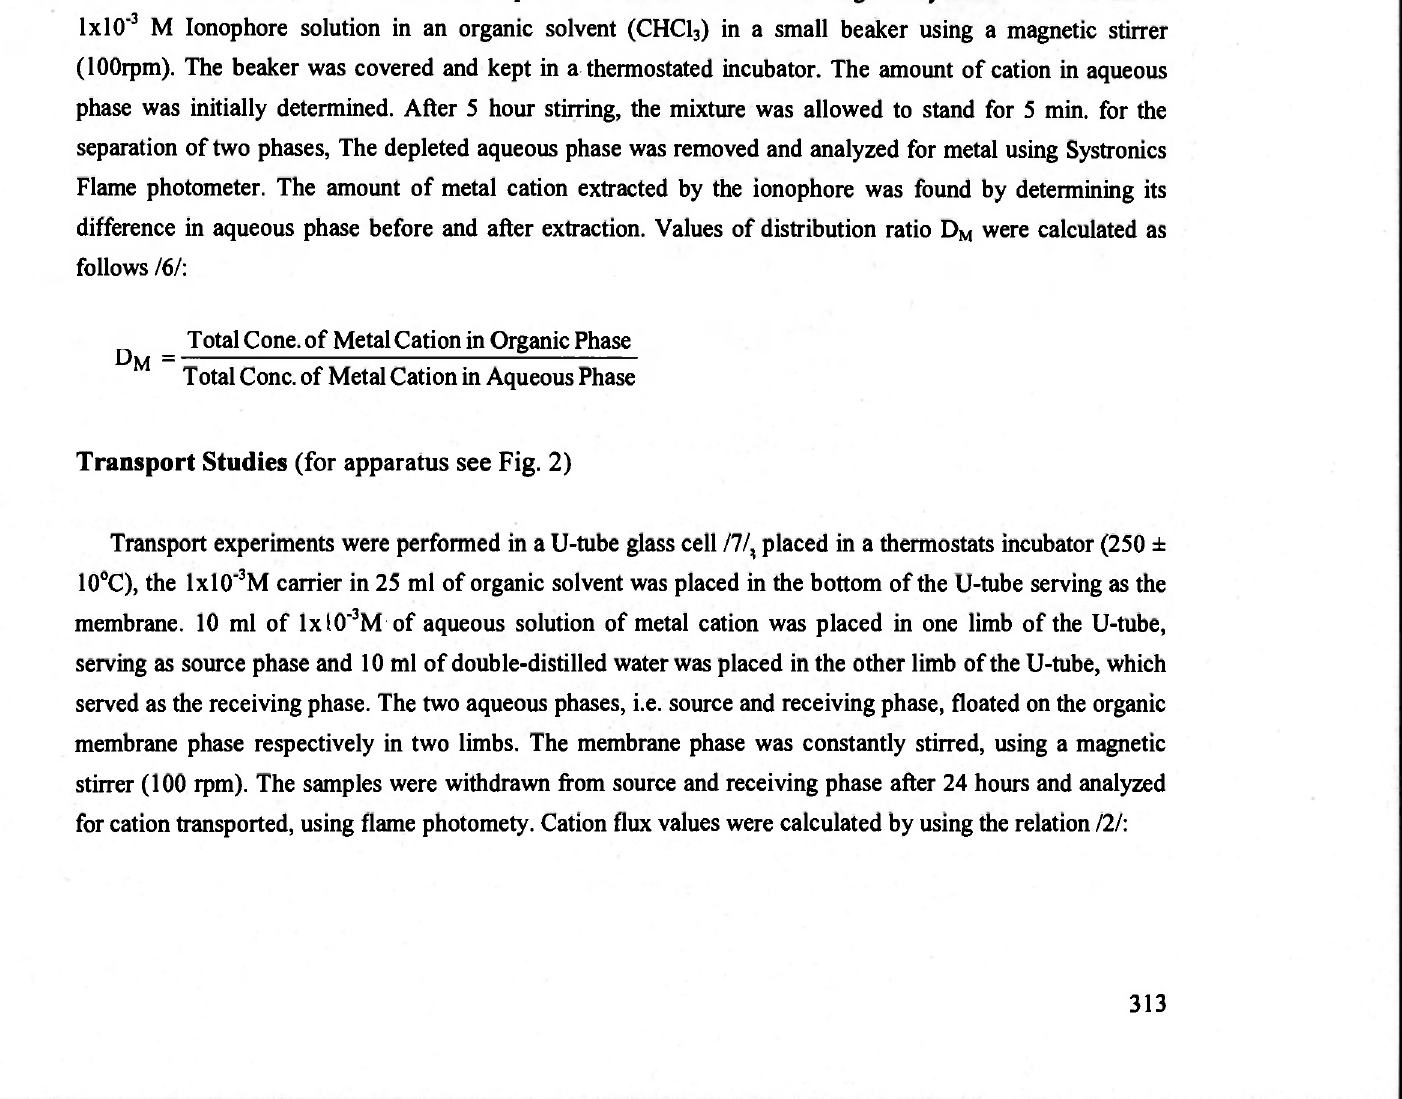
Fig. 1: Apparatus for extraction